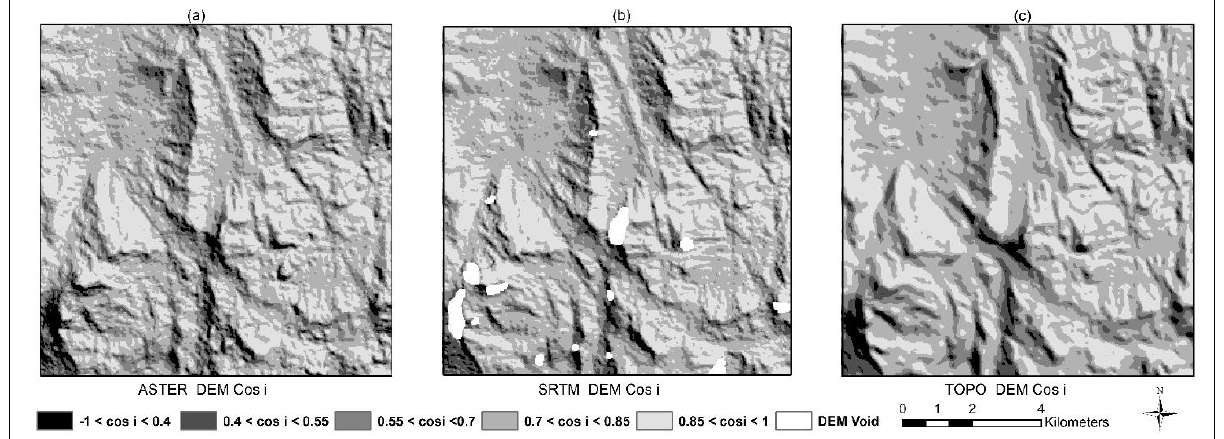
Figure 3. Five cos i classes based on (a) ASTER DEM, (b) SRTM DEM and (c) TOPO